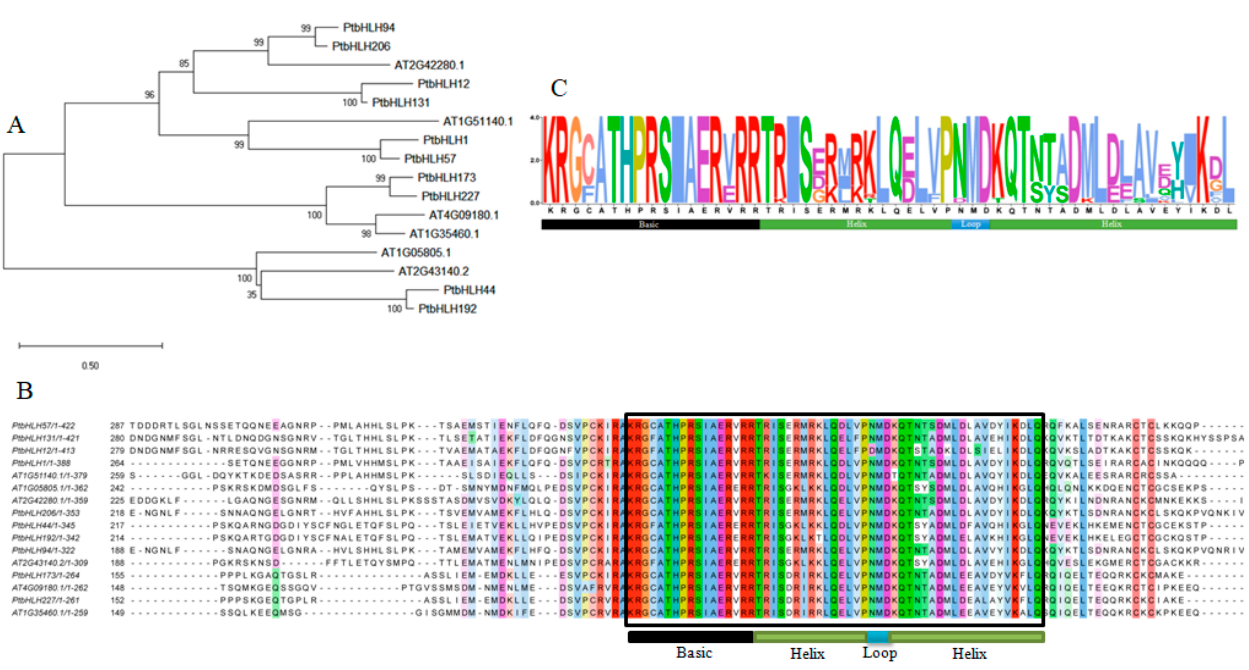
Figure 5. Multi-sequence alignment and domain analysis of the FBHs in poplar. ( A ) The phylogenetic analysis of FBHs gene family in poplar and Arabidopsis . ( B ) Conserved domains in FBHs proteins are marked with a black box and indicated. Sequence alignment was generated by DNAMAN 6.0 software. ( C ) Sequence logo was built by online software WebLogo.